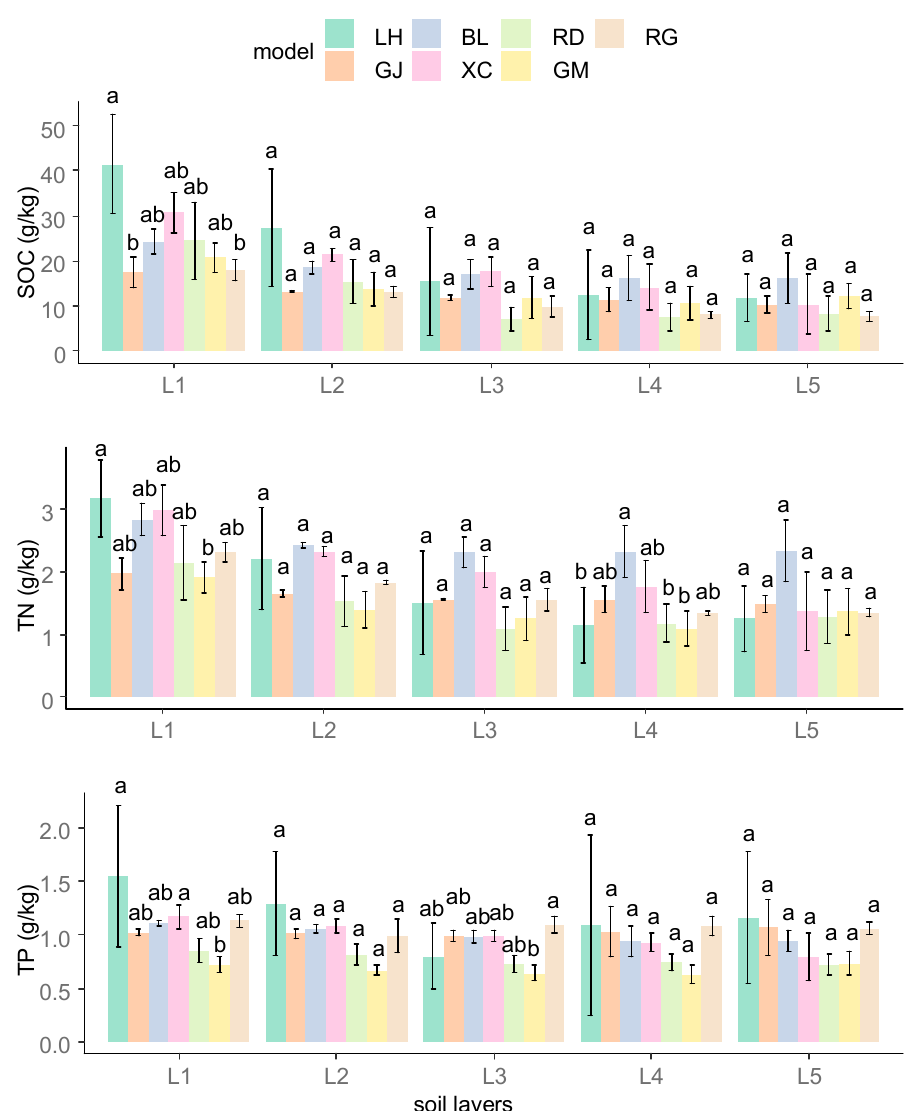
Figure 2. Contents of SOC, TN, and TP in the different restoration models for each soil layer. Different small letters mean significant differences among restoration models in the different soil layers. Table 2. F and p -values of the independent factors (models, layer) and their interactions.